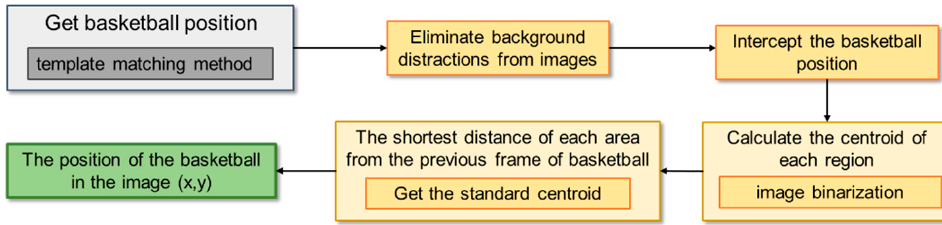
Figure 2. Basketball position acquisition process.